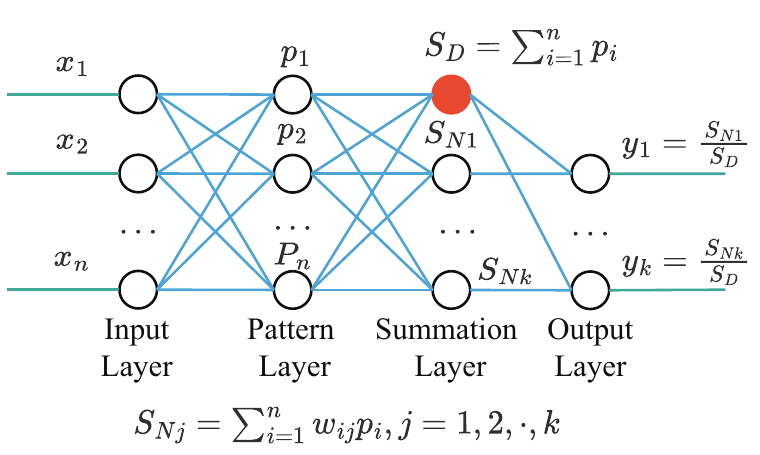
Figure 5. The GRNN